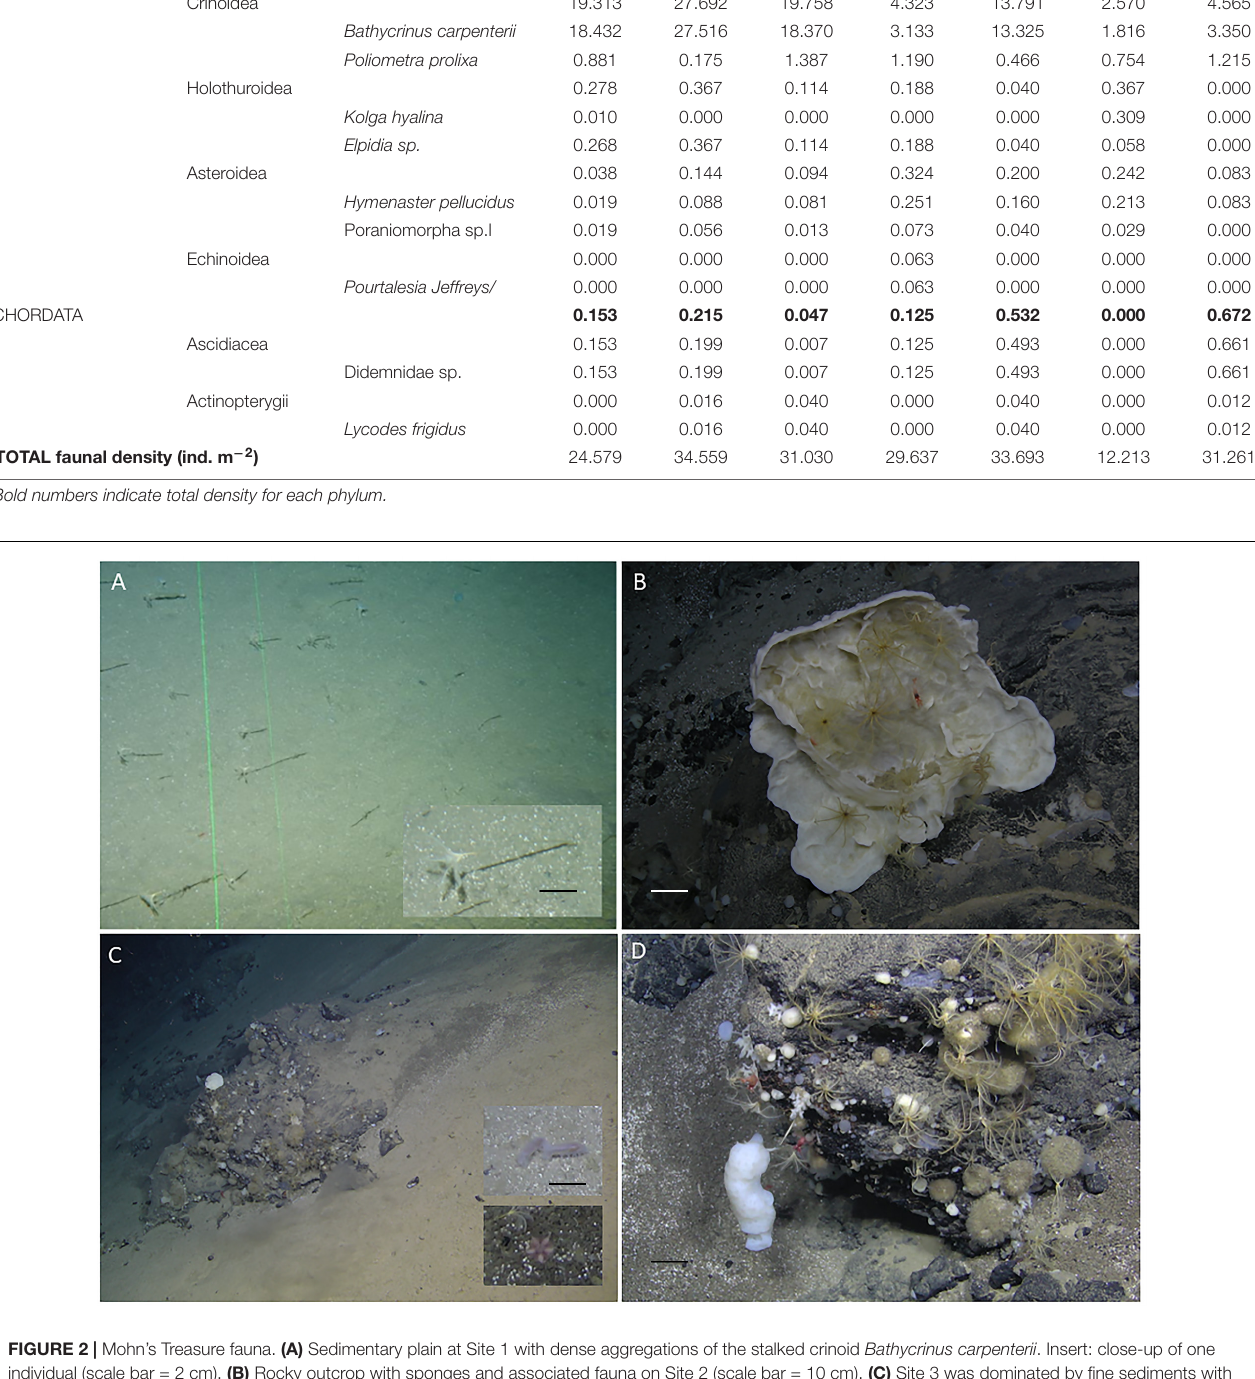
Frontiers in Marine Science |